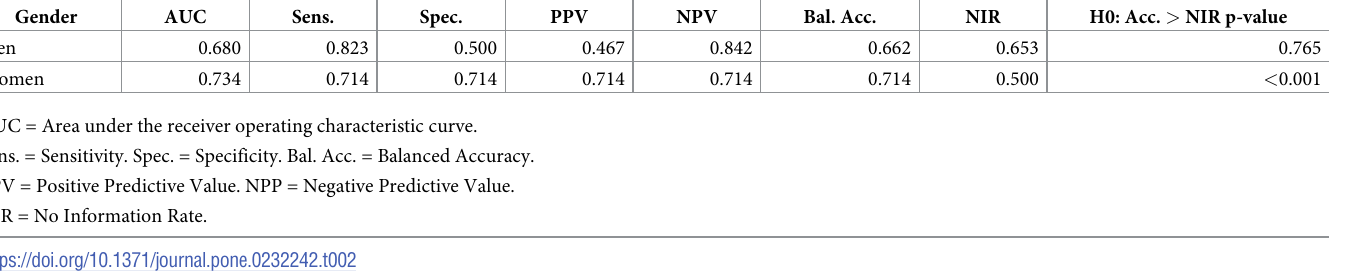
Table 2. Evaluation of the Random Forest models.